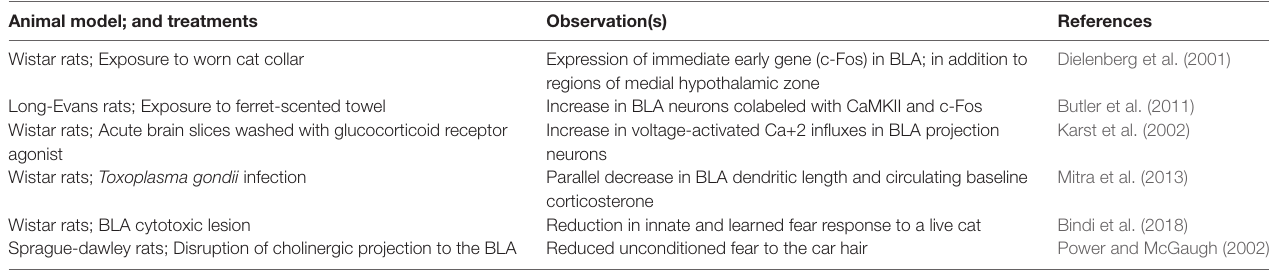
TABLE 1 | Q4 Role of basolateral amygdala (BLA) in defensive behaviors. Animal model; and